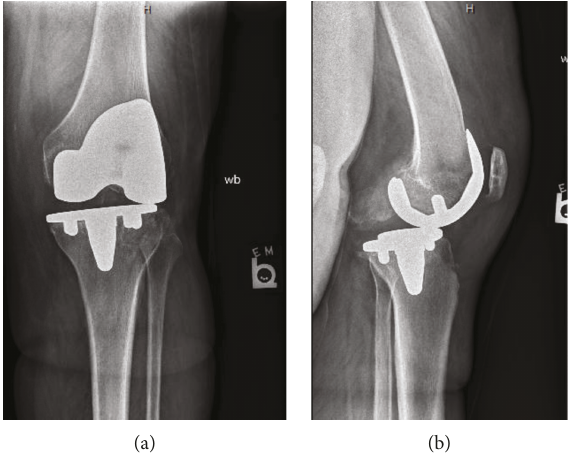
Figure 2: (a, b) AP and lateral radiographs of the knee indicating posterior dislocation of the tibia and instability of knee prosthesis. Note inability to ascertain the direction of the rotating